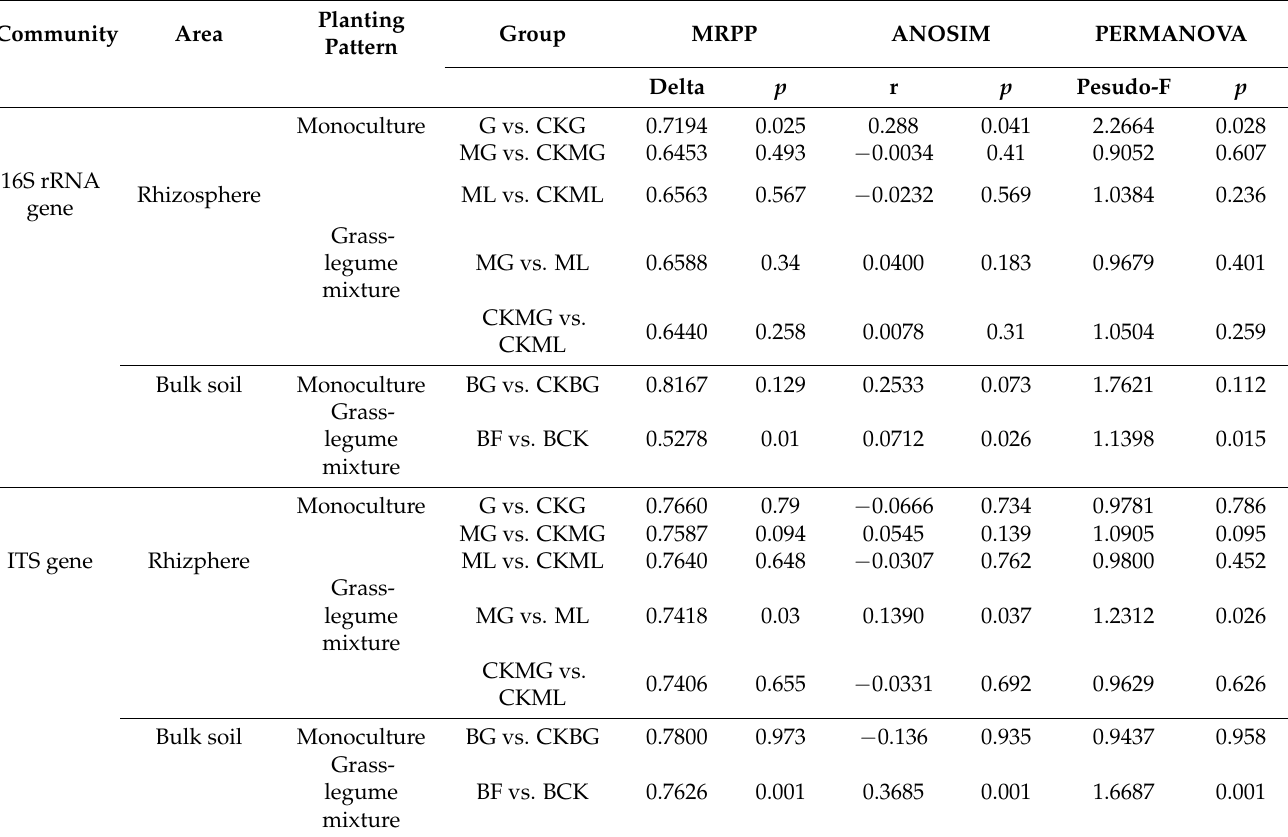
Table 1. Dissimilarity test by MRPP, ANOSIM, and PERMANOVA based on Jaccard dissimilarity between planting systems. In the monoculture, G represents rhizosphere samples of OF; CKG represents rhizosphere samples of non-OF; BG represents bulk soil samples of OF; CKBG represents bulk soil samples of non-OF. In the grass–legume mixture, MG represents rhizosphere samples of grass OF; CKMG represents rhizosphere samples of grass non-OF; ML represents rhizosphere samples of legume OF; CKML represents rhizosphere samples of legume non-OF; BF represents bulk soils samples of OF; BCK represents bulk soil samples of